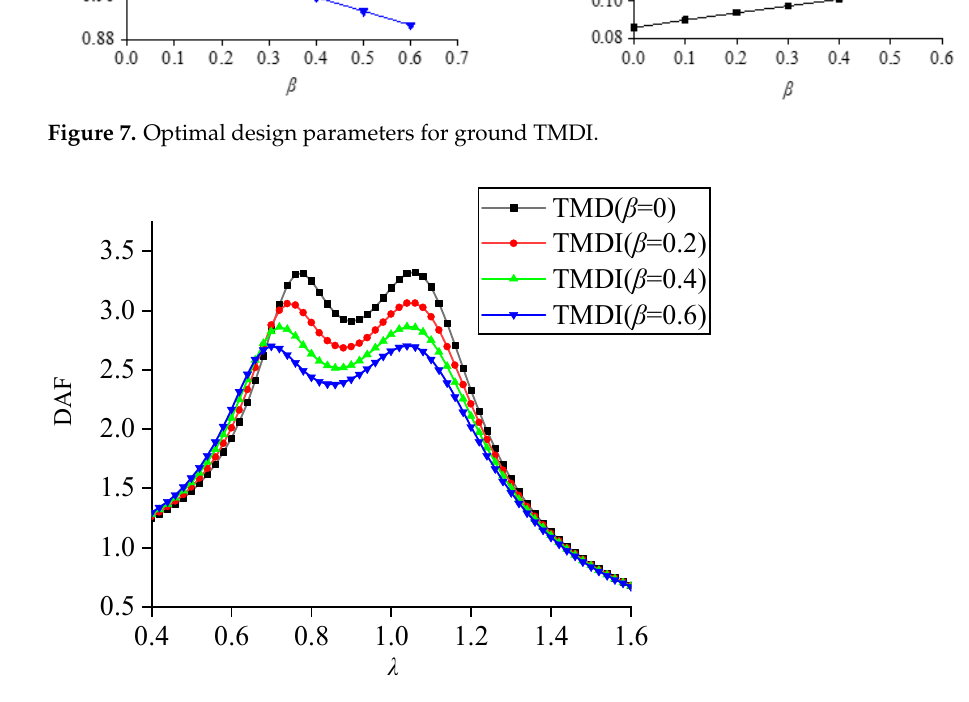
Figure 8. Frequency response curve comparison.